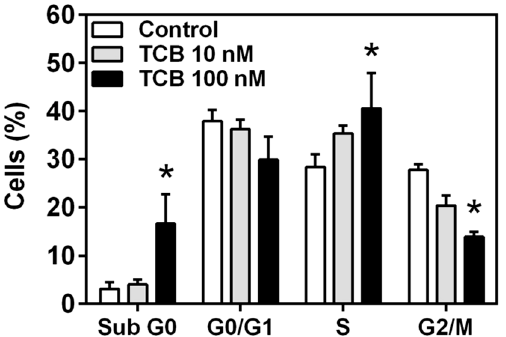
Figure 5. Cell cycle analysis of LLC-PK1 cells treated with telocinobufagin (TCB) by flow cytometry. Serum-starved LLC-PK1 cells were treated with 10 and 100 nM TCB in 2.5% FBS for 48 h. Distribution of cells in the sub G0, G0/G1, S and G2/M phases of the cell cycle. Data are the mean ± SEM of three independent experiments in duplicate. * p < 0.05 vs. control.